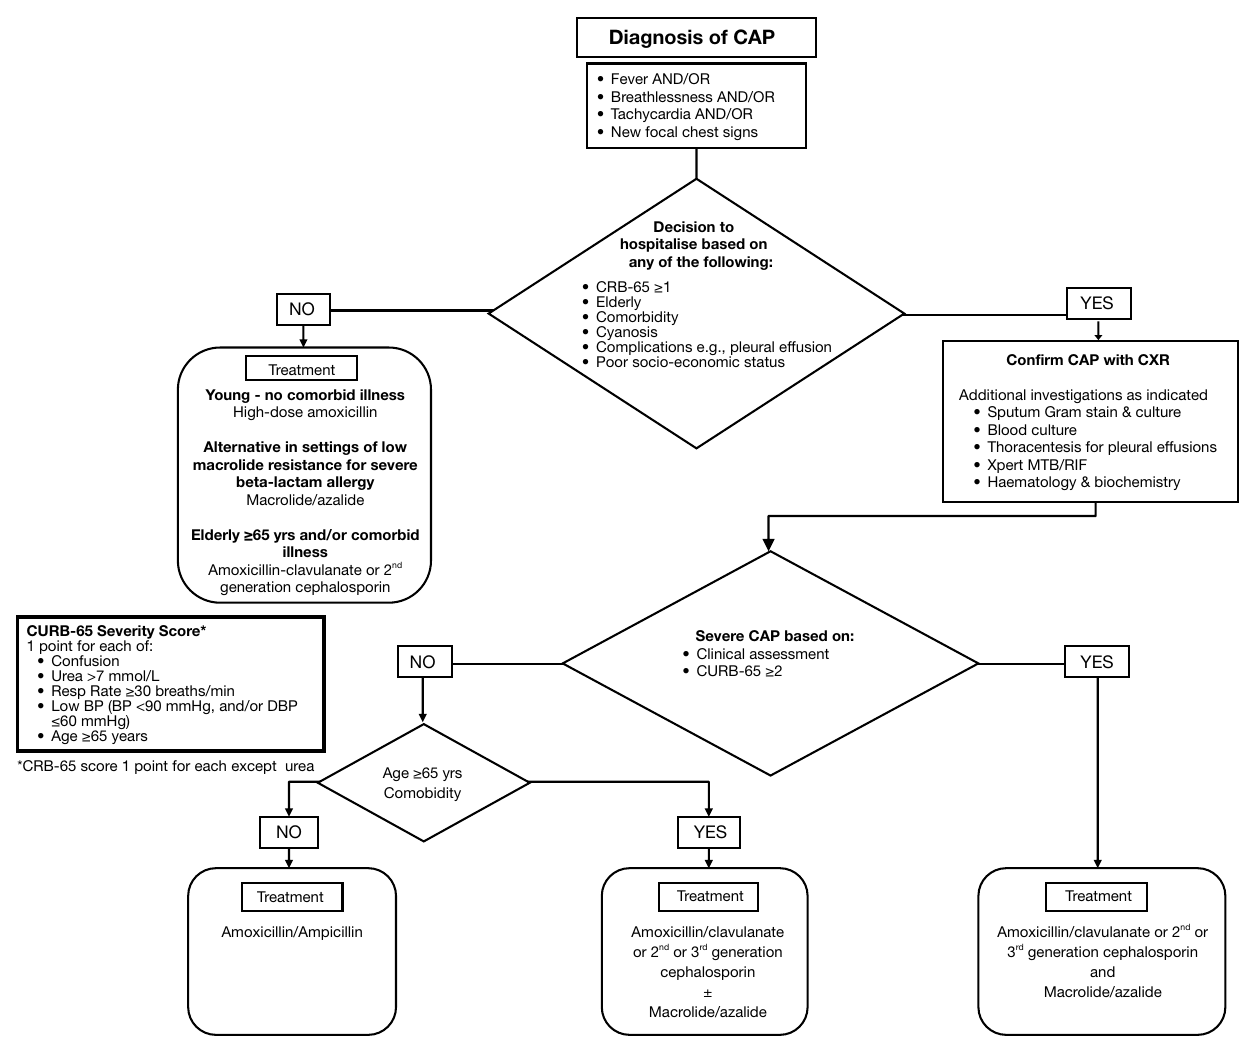
Figure 1 Algorithm for the management of community-acquired pneumonia in adults in South Africa. This figure should be read in conjunction with the text. Adapted with permission from the South African Medical Journal (S Afr Med J 2007; 97: 1295 – 1306).